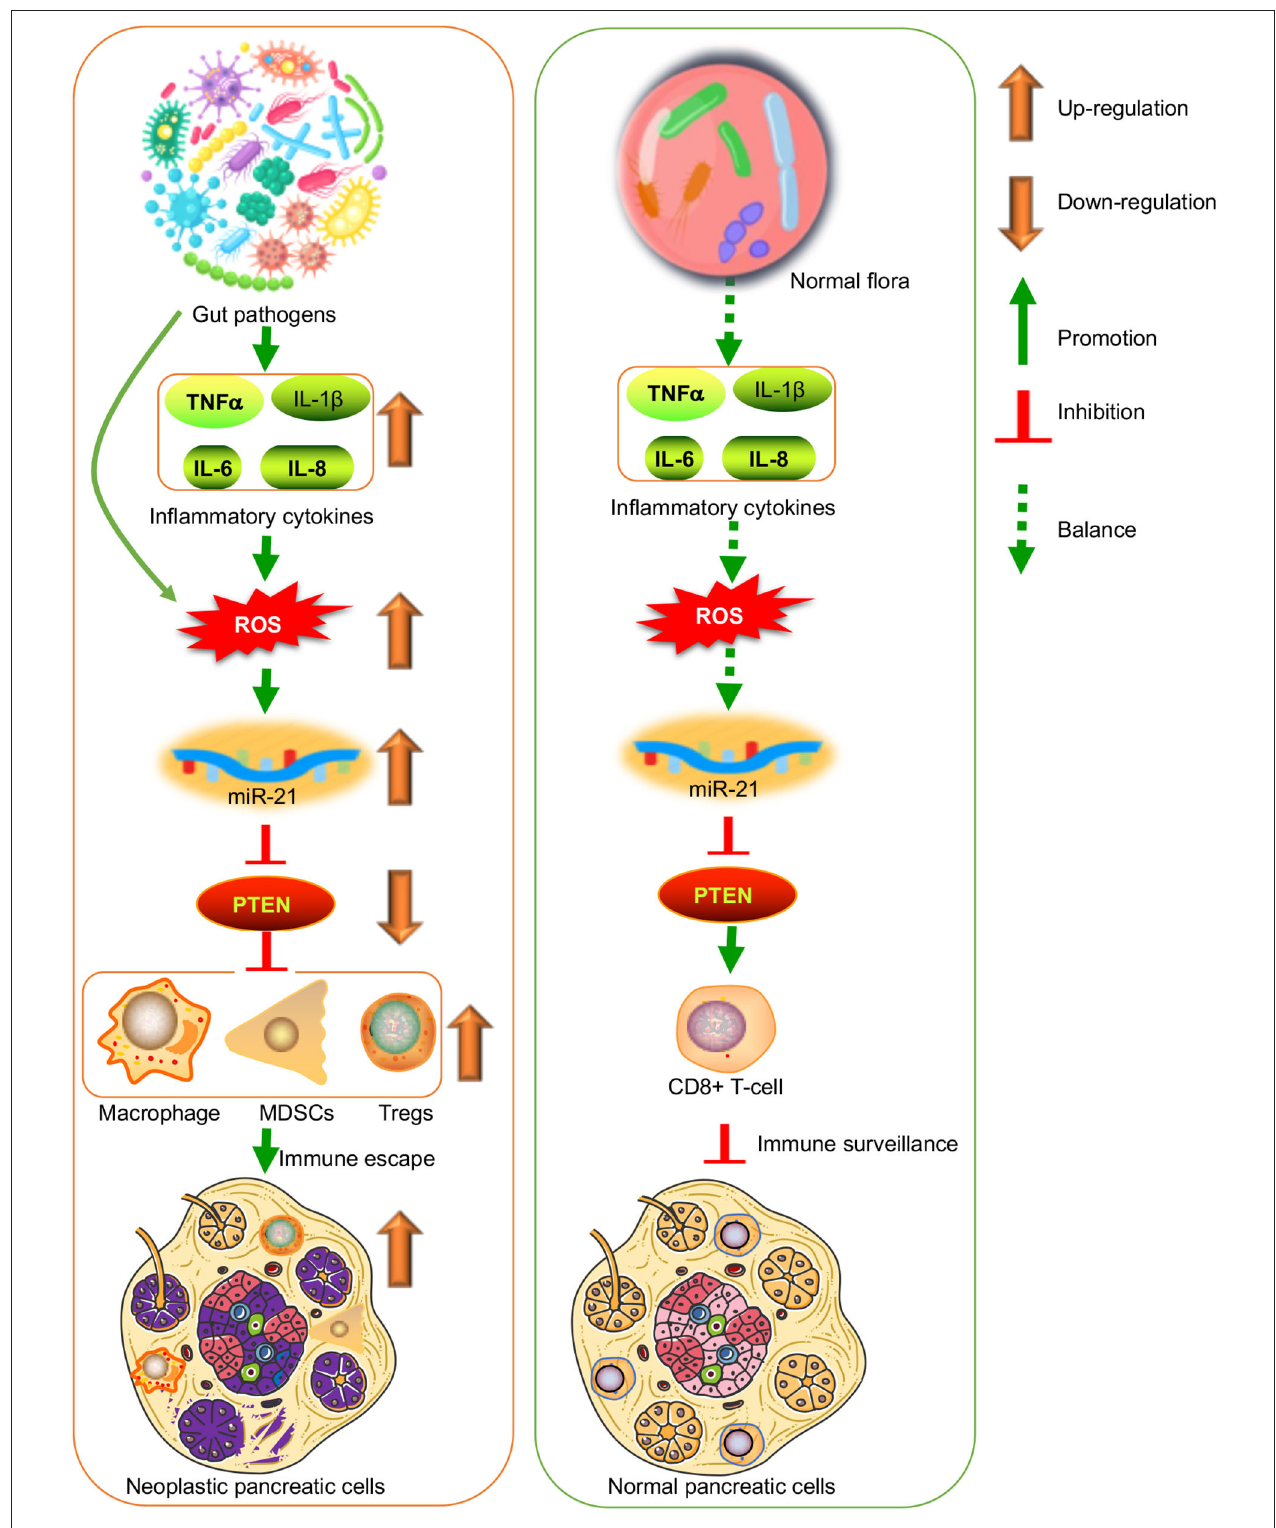
FIGURE 1 | Oral-gut pathogens induce the immune escape of pancreatic cancer by affecting miR-21/PTEN axis via inflammatory cytokines-induced reactive oxygen species (ROS). It is suggestive that pathogen infection has long-term effects to stimulate inflammatory cytokines. Most of these cytokines can induced ROS products, which induce miR-21 expression and functions. Phosphatase and tensin homolog deleted on chromosome ten (PTEN) is a direct target of miR-21 and the